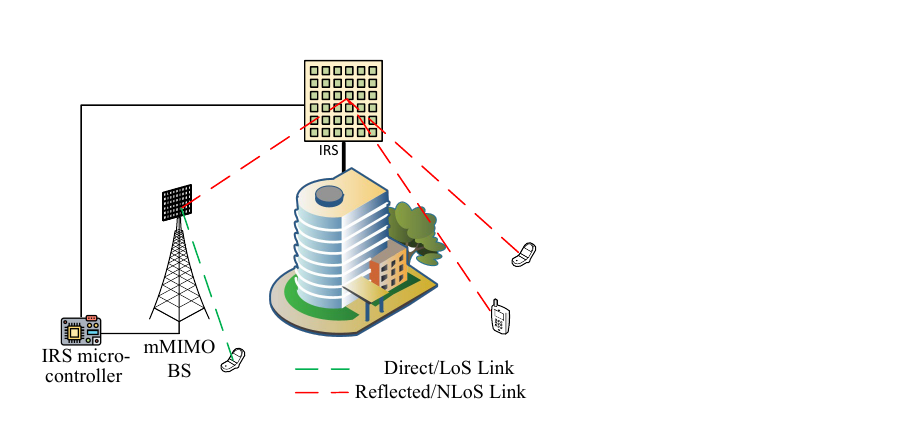
Figure 5. This diagram shows a Reconfigurable Intelligent Surface (RIS)-assisted communication system.